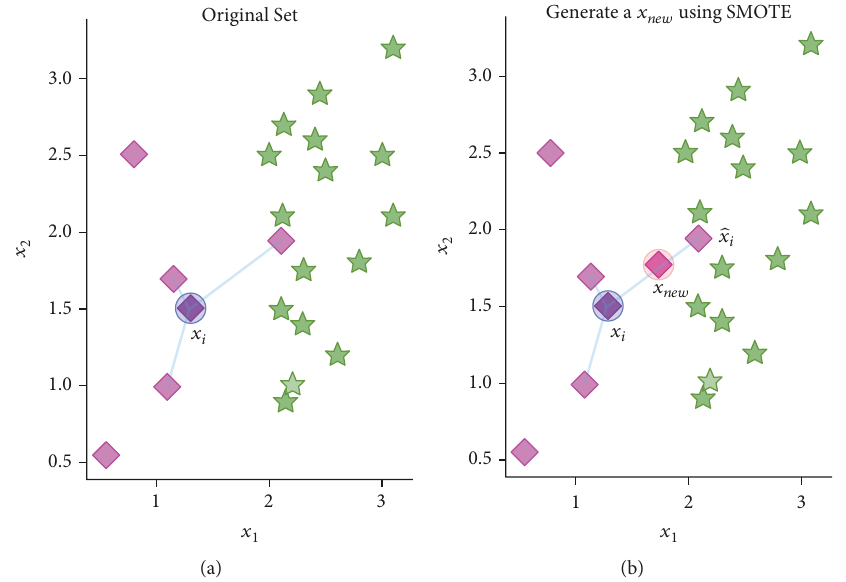
Figure 2: A toy example of the three-nearest neighbors for the x 𝑖 (a); and generate x 𝑛𝑒𝑤 using SMOTE (b).